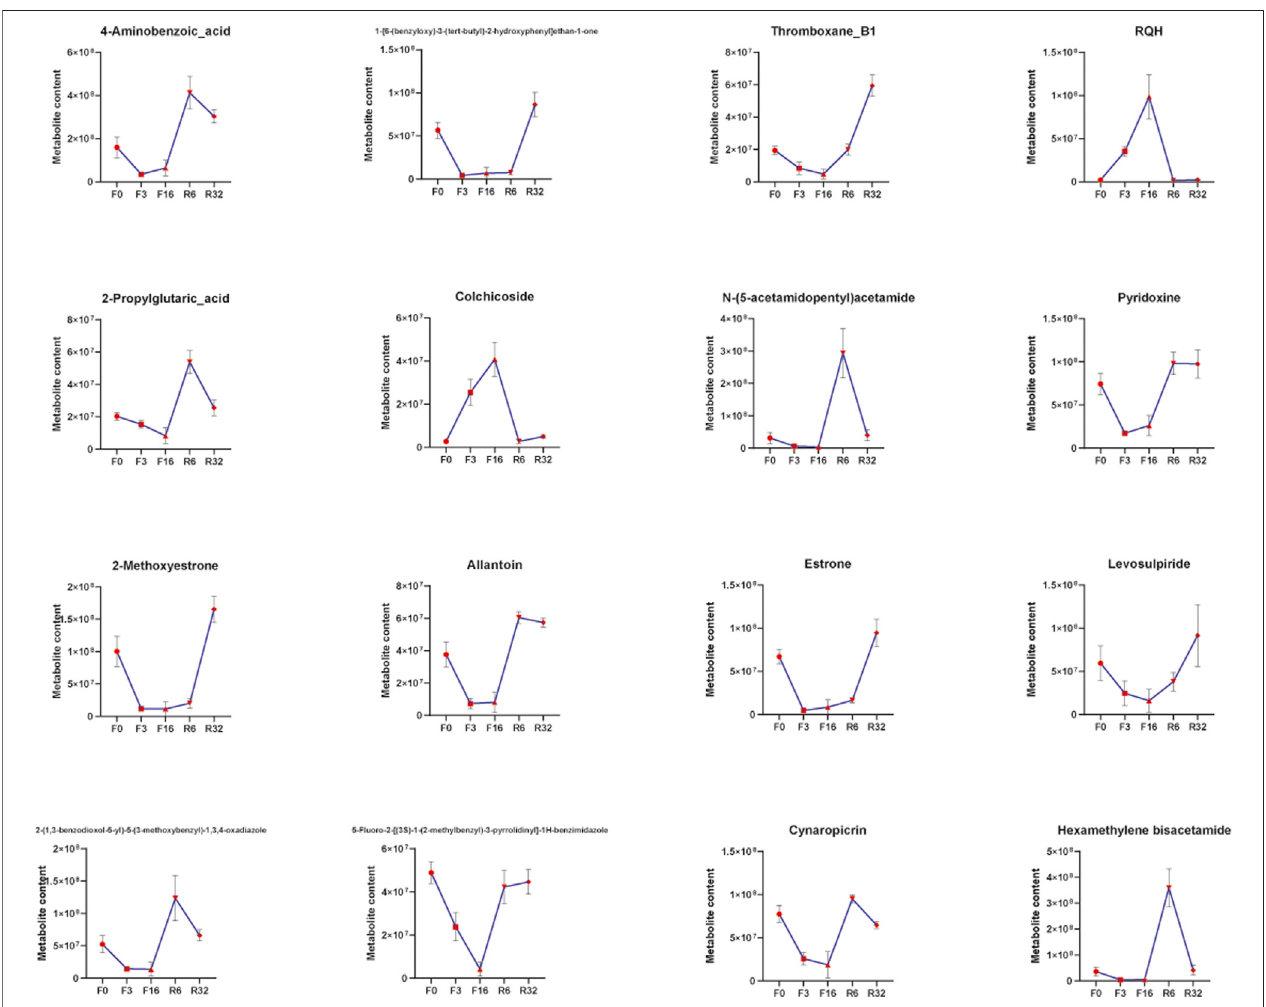
FIGURE 9 | Changes in metabolite content during